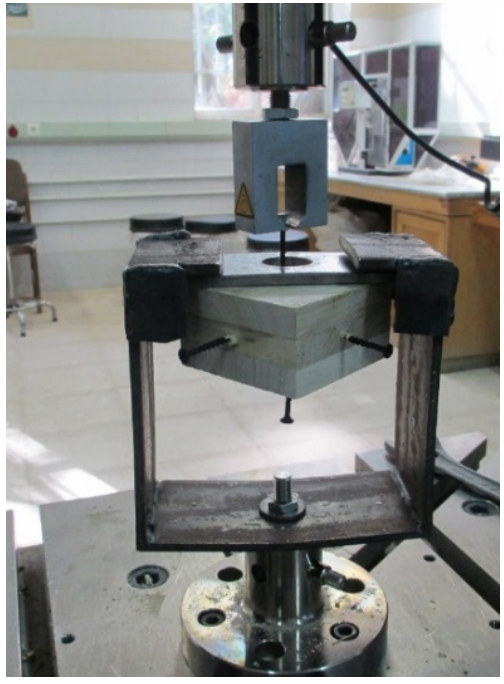
Figure 3. Instron machine for testing withdrawal resistance of the fasteners.